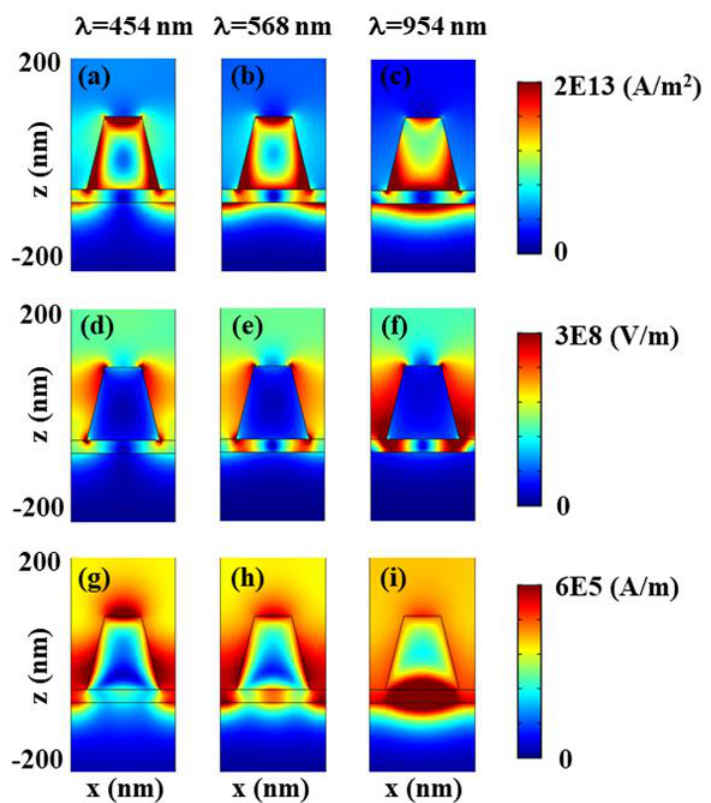
Figure 3. ( a – c ) Current density norm distributions (in units of A/m 2 ) indicating the origin of the energy loss resulting in the enhancement of the broad bandwidth of absorption, ( d – f ) E-field norm distributions (in units of V/m) indicating the excitation of surface plasmon resonances at metal – dielectric – metal interfaces, ( g – i ) H-field norm distributions (in units of A/m) indicating the local surface plasmon resonances located in the dielectric gap. All these distributions are observed at the resonant wavelengths of 454, 568, and 954 nm in the XZ-plane, respectively.